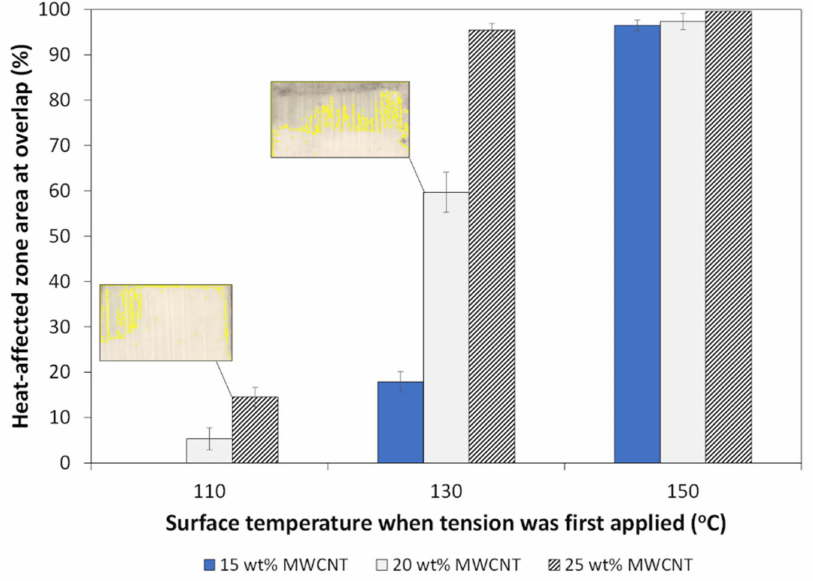
Figure 13. Estimated heat-affected zone area in GF/PP adherends after disassembly procedure at difference surface temperatures, based on adherends’ surface color images presented in Figure 11. Two examples of delineated areas are shown in